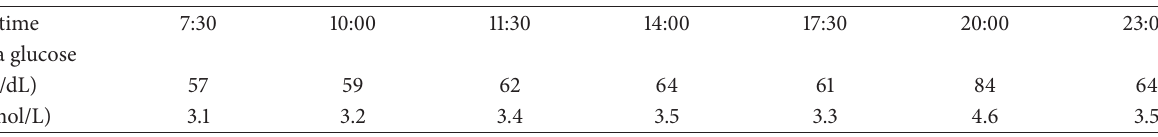
Table 2: Results of examinations at first visit. (a) Glucose diurnal